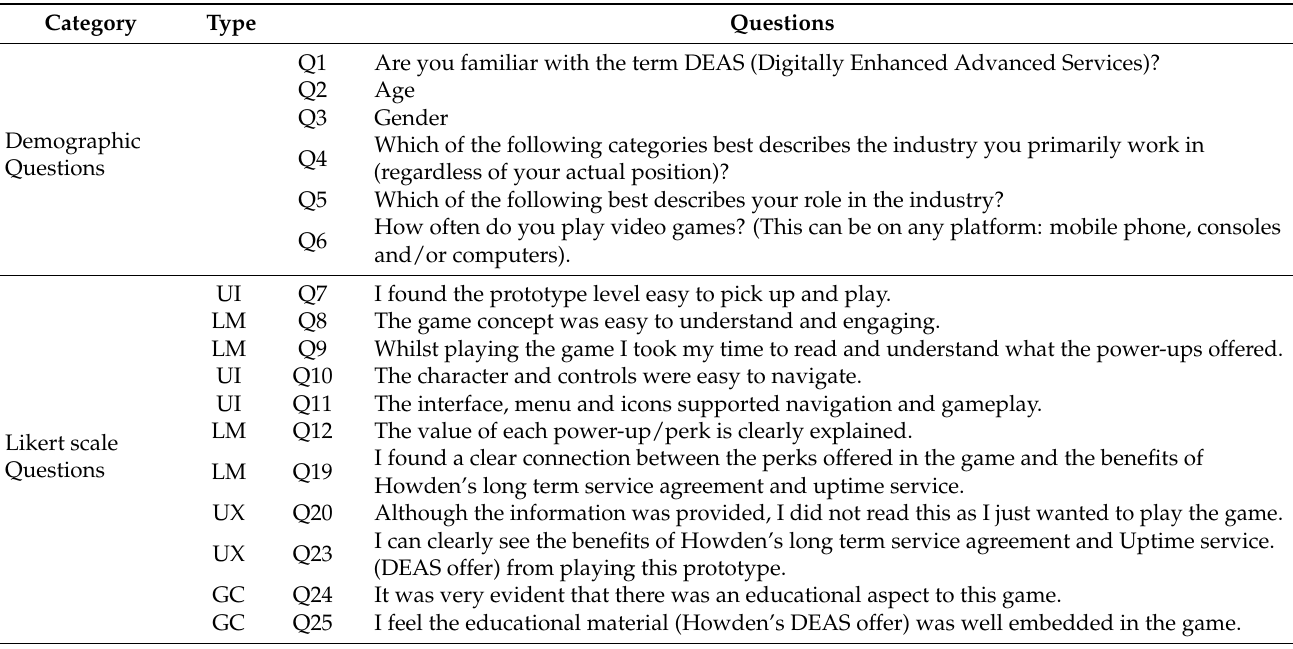
Table 2. Breakdown and categorization of the questions asked during the